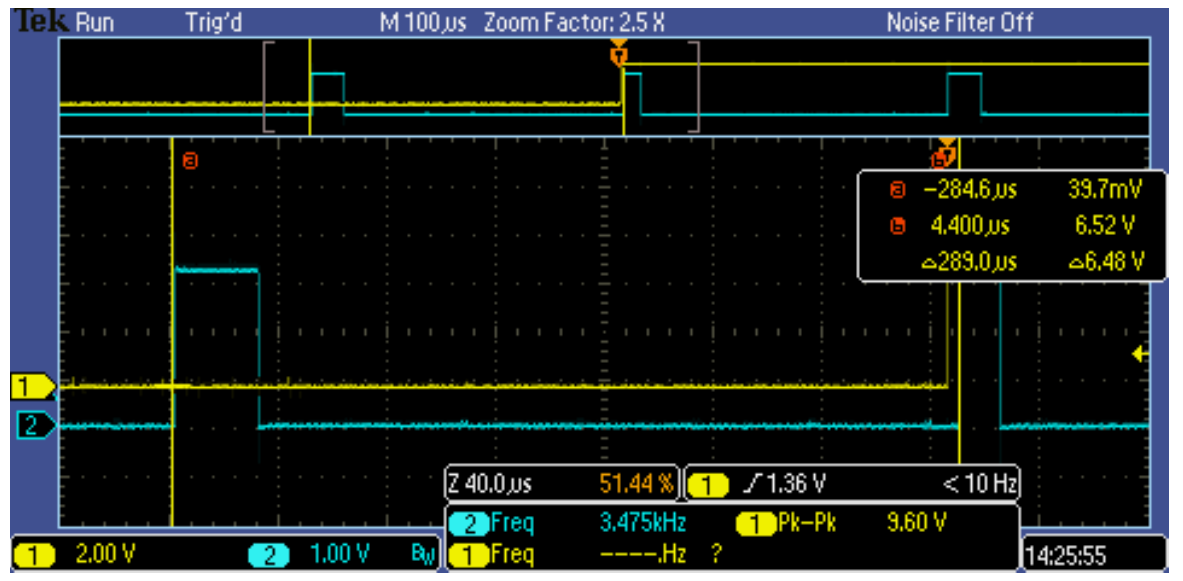
Figure 25. Oscilloscope capture of 3.2 kHz falling edge timing after PPS signal.